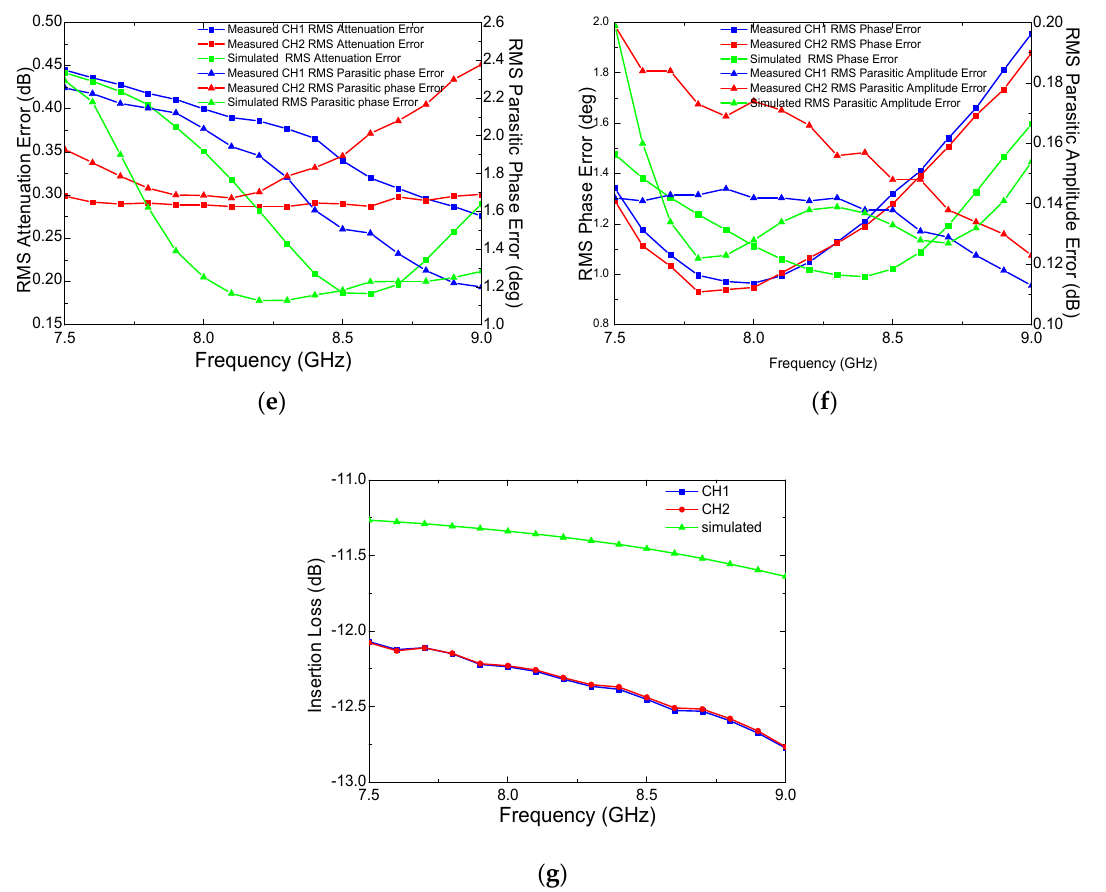
Figure 9. ( a ) Measured channel 1 (CH1) input and output return loss of all states, ( b ) measured channel 2 (CH2) input and output return loss of all states, ( c ) measured relative attenuation of all states, ( d ) measured relative phase shift of all states, ( e ) measured and simulated CH1 and CH2 root mean square (RMS) error of attenuation and parasitic phases, ( f ) measured and simulated CH1 and CH2 RMS error of phase and parasitic amplitude, ( g ) measured and simulated CH1 and CH2 insertion loss.